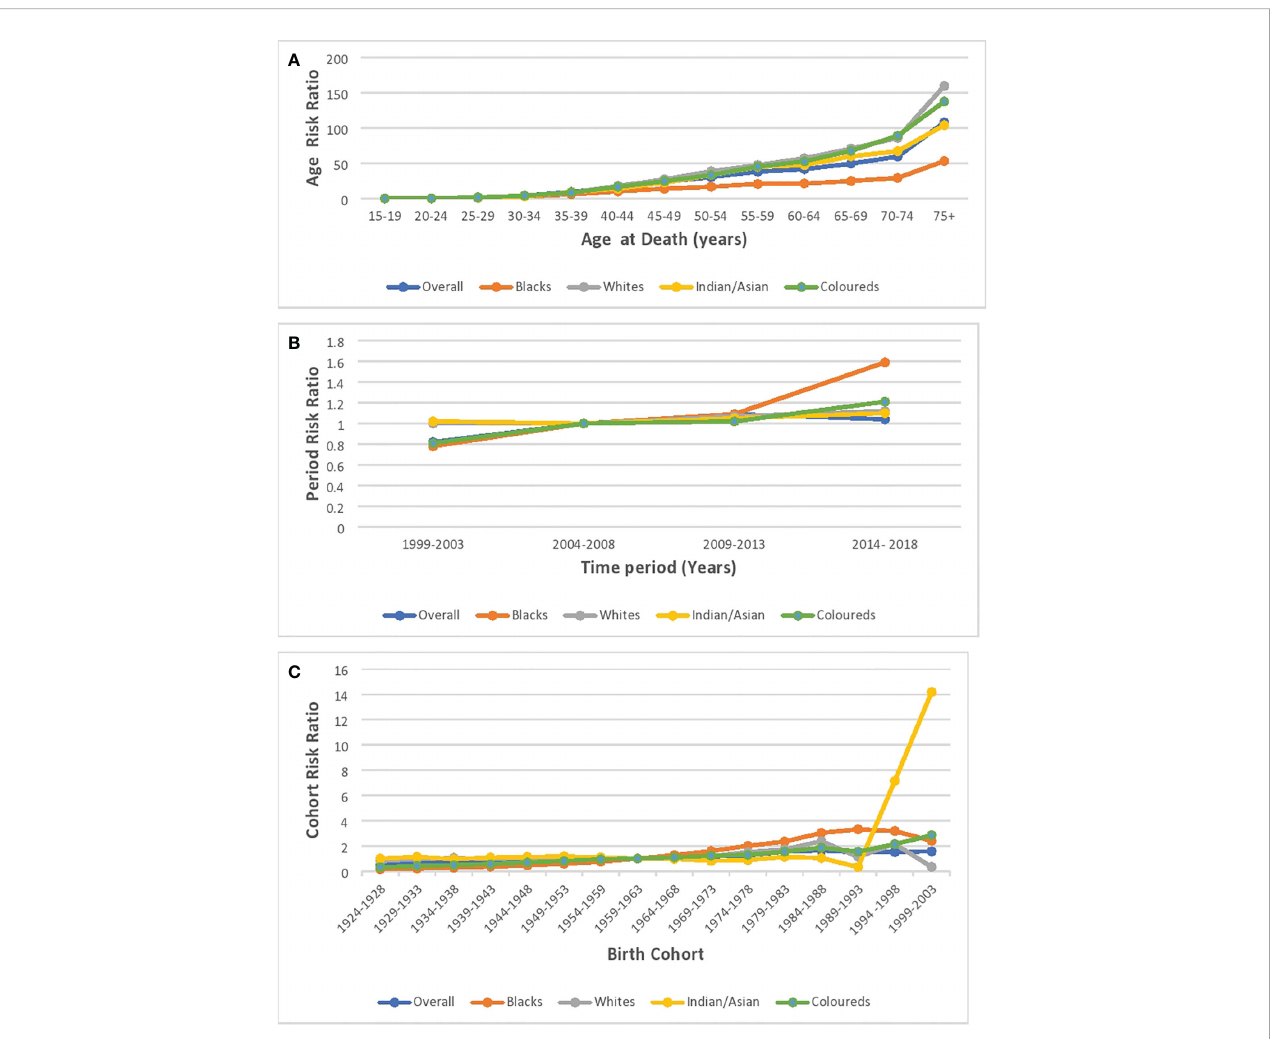
FIGURE 11 Ethnic and national breast cancer mortality risk ratio in South Africa due to (A) age, (B) period, and (C) cohort after the age – period – cohort